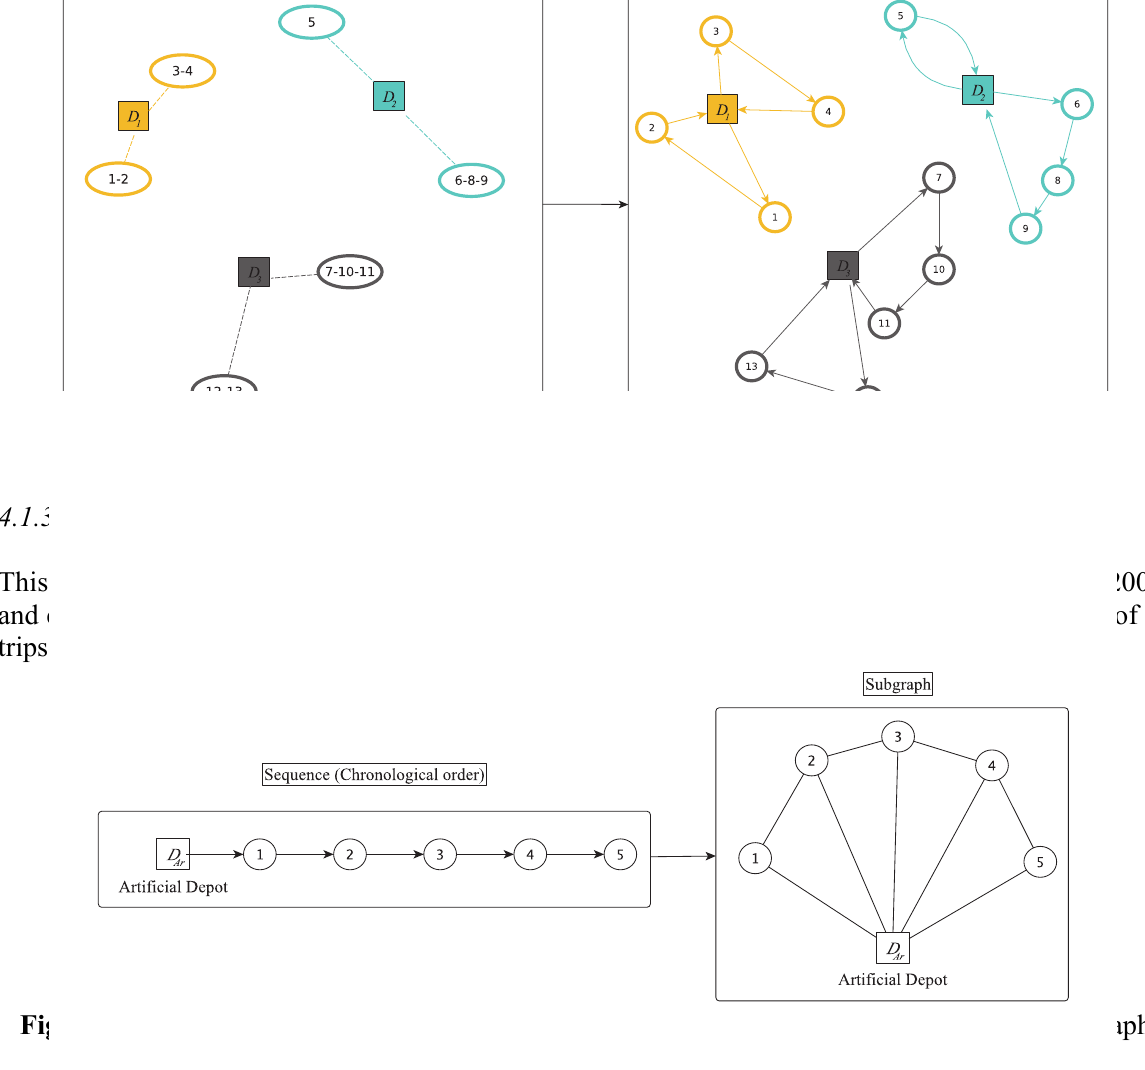
Fig. 7. Assignment of resolved supernodes